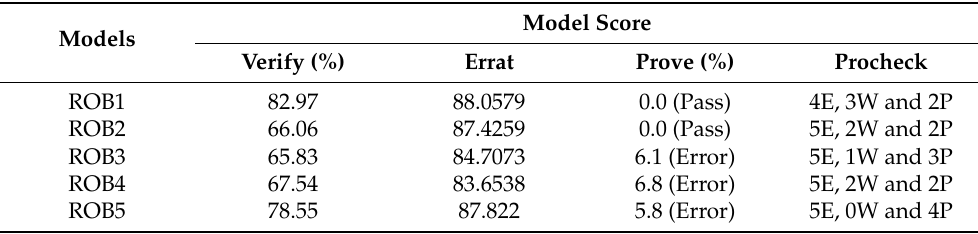
Table 4. Model evaluation of the Robetta predicted models using SAVES